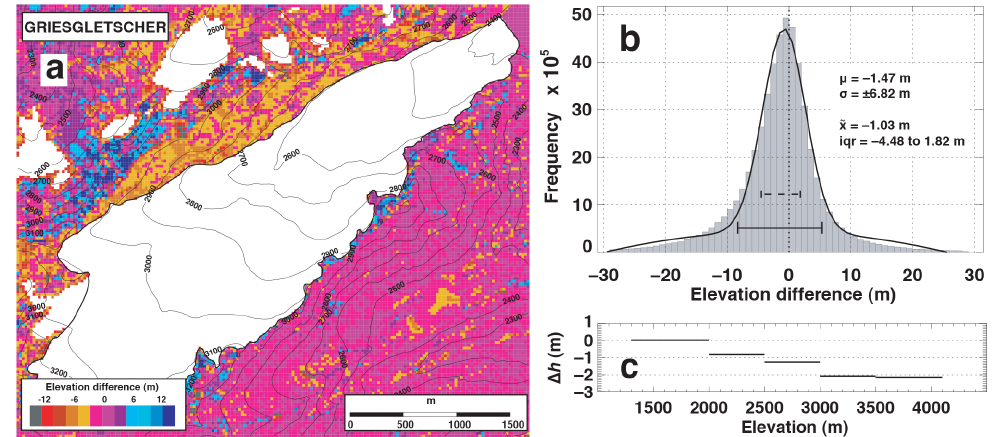
Figure 5. Comparison of input DEMs over stable terrain. (a) Spatial distribution of DEM differences outside the 1973 extents of Gries- gletscher and adjacent smaller glaciers (masked out in white). (b) Frequency distribution of DEM differences over stable terrain around all glaciers. The black curve is a normal fit over the data, the solid bar marks standard deviation at the 1 σ level and the dashed bar marks the interquartile range (iqr). In addition, the mean ( µ ) and median ( e x ) elevation differences are given. (c) DEM differences over stable terrain around all glaciers averaged over 500m elevation